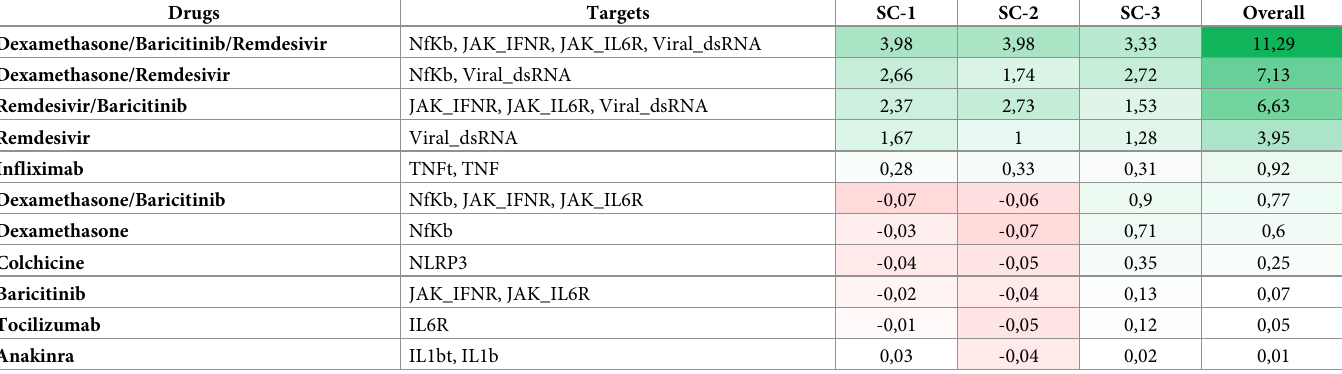
Table 2. Drug therapies and their efficacy scores. Drug therapies were simulated with their molecular targets and the drug-specific scores computed for each scenario. The overall score is the sum of the previous scores and serves as a general performance indicator. The scoring formula is explained in Materials and Methods. Each score in the specific scenarios is from -4 to 4 and considers the advantages of the cell in terms of enrichment of the favorable phenotypes or reduction of the unfavorable ones. The overall score has a minimum and a maximum, respectively, of -12 and 12. Drugs are sorted according to the overall score to highlight those that are predicted to per- form